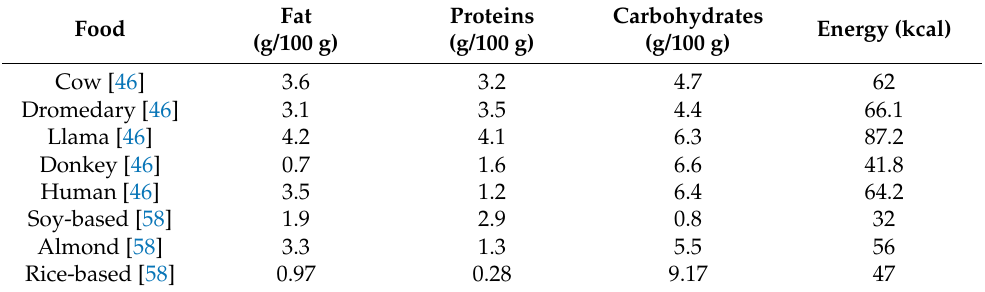
Table 5. Chemical composition comparison among mammalian’s milk and plant-based